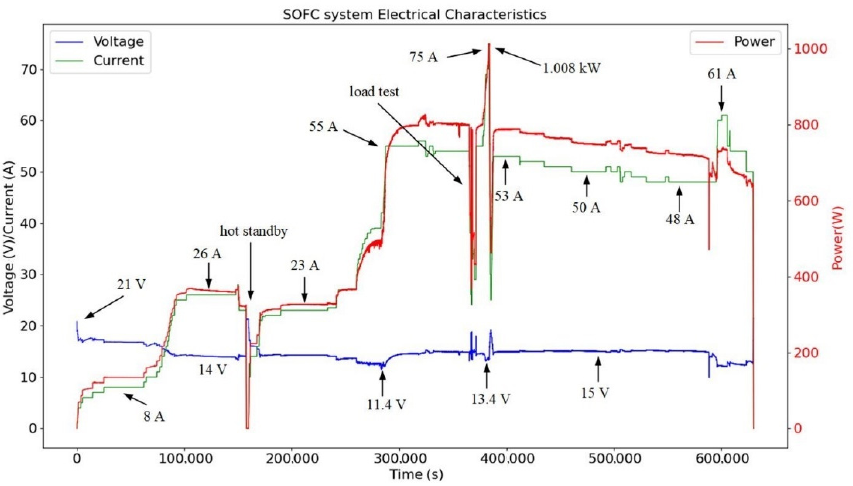
Figure 3. SOFC system voltage-current curve.